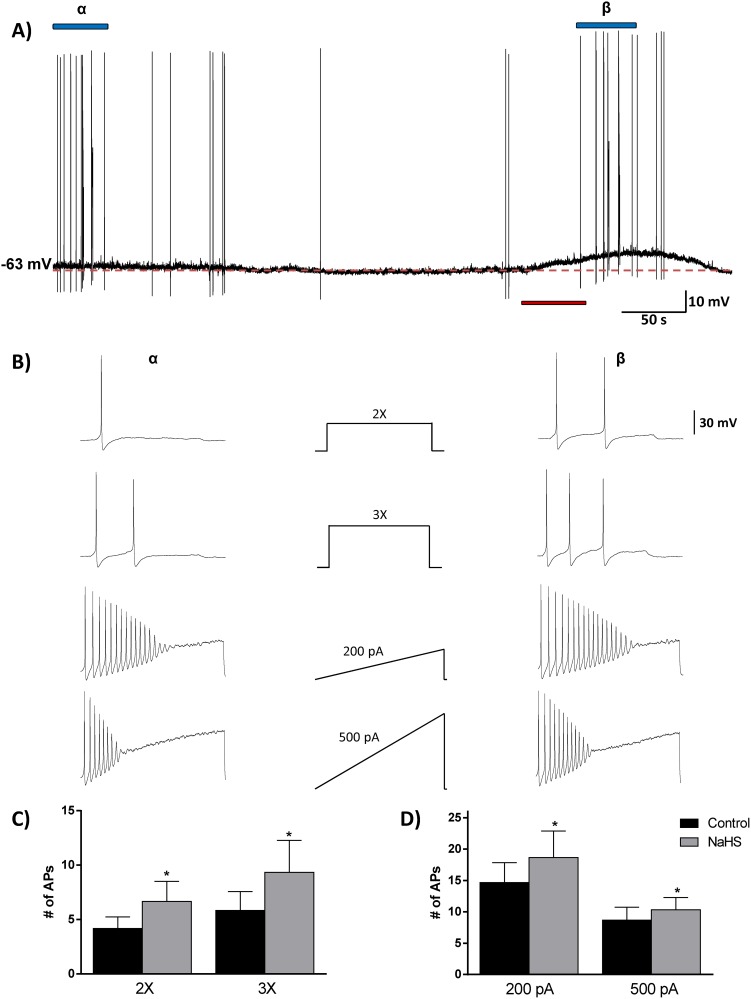
Hydrogen sulfide increases the excitability of SFO neurons.An analysis of rheobase and action potential firing frequency revealed an increase in excitability. (A) Current clamp trace with red bar indicating application of NaHS (1 mM), and blue bars (α and β) indicate periods when current injection protocol was performed. (B) The middle panel shows the current injection protocols for 2X and 3X rheobase steps, and 0–200 and 0–500 pA ramps, while the spike patterns induced are shown for the control (left panel, α) and NaHS (right panel, β) conditions. Bar graphs displaying the mean number of action potentials before (black) and during (grey) NaHS application for the current step (C) and ramp (D) protocols. Note the increase in action potential number in response to NaHS in all 4 cases. *p<0.05, paired t test.